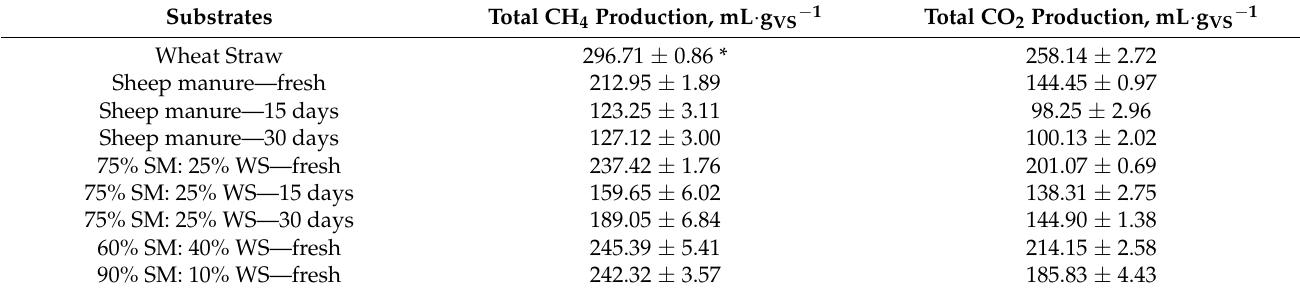
Figure 3. Carbon dioxide yields ( a ) and cumulative carbon dioxide productions ( b ) from the anaerobic mono- and co-digestion of each substrate. Different letters above the bars signify distinct statistical groups ( p < 0.05) between the different tests. The bars designate the standard deviation. Table 4. Total volume of methane and carbon dioxide production from the tested